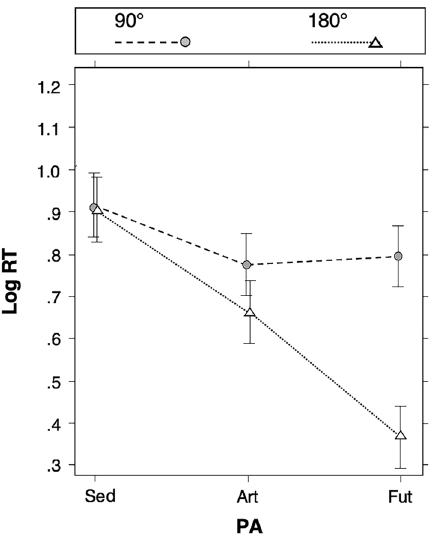
Figure 1. Effects of the interaction between PA and d° (PA*d°) on log RTs. The effect-plot 41 shows the adjusted mean MR task performances (log RT) in each PA (physical activity) group (sedentary subjects, Sed, artistic gymnasts, Art and futsal players, Fut) according to the degrees of the rotation imagined (d°: 90° or 180°). The vertical line segments indicate ± 95% confidence interval. In each d° condition, broken lines connect the log RT values of the PA groups to emphasize the interaction